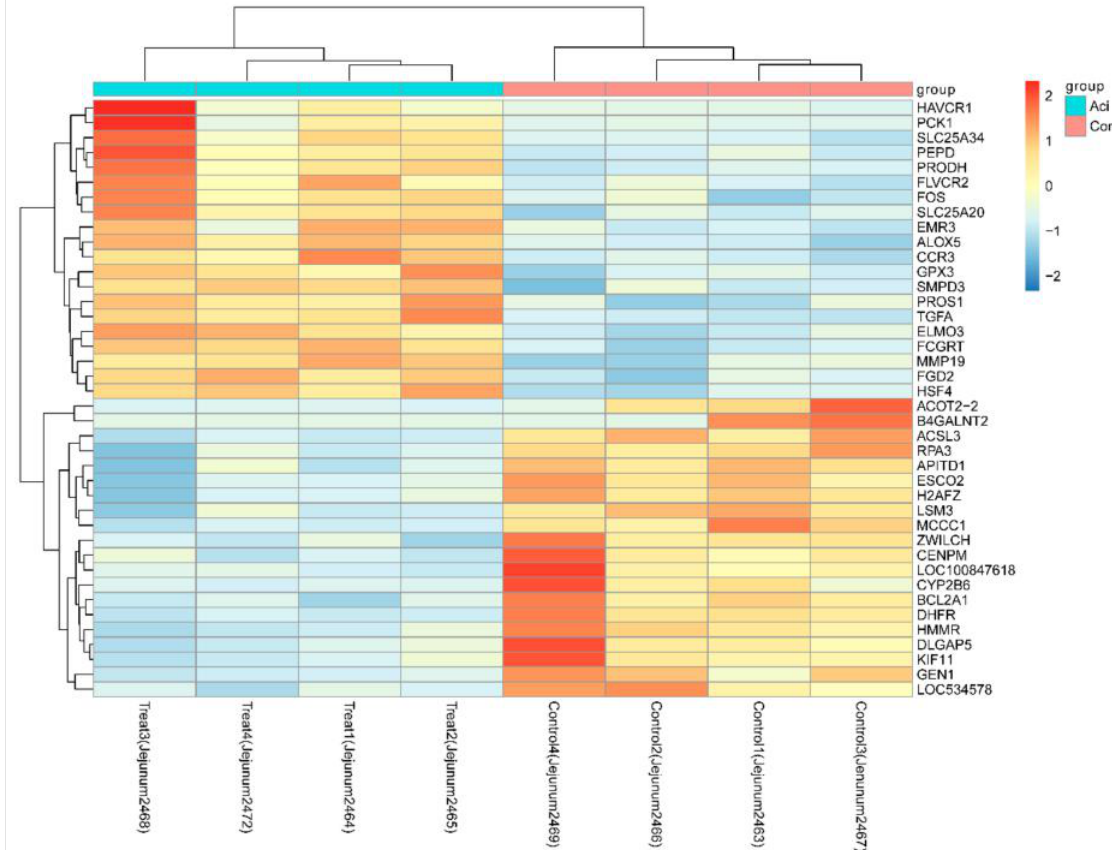
Figure 1. Heatmap showing top 40 DEGs between treatments. The log2 ratio values of DEG abundance were used for cluster analysis with the R pheatmap package. Red and blue indicate relative over- or under-expression of genes, respectively. Aci, feed-induced acidosis group; Con, control